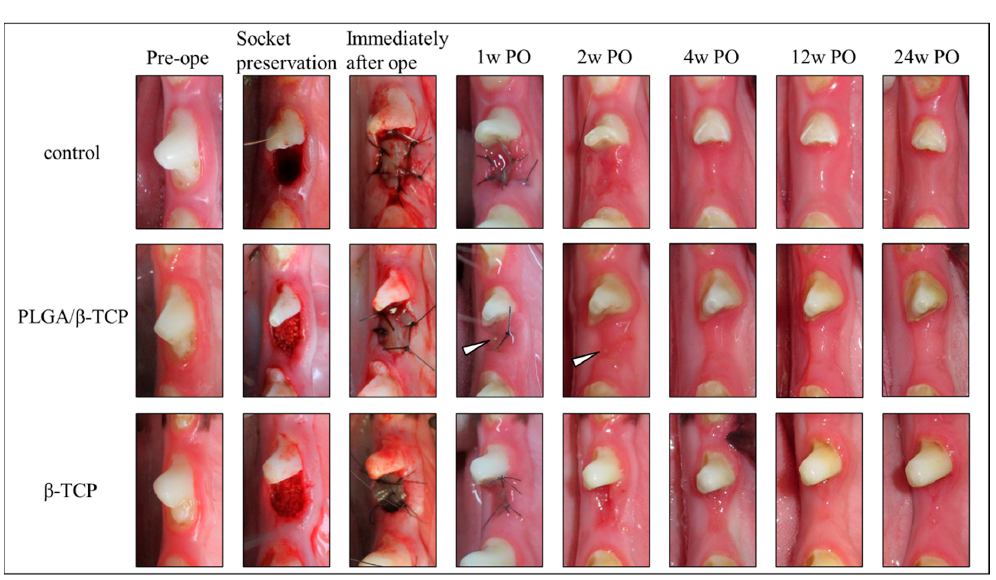
Figure 2. Pre-operative images and post-operative wound healing cascade.